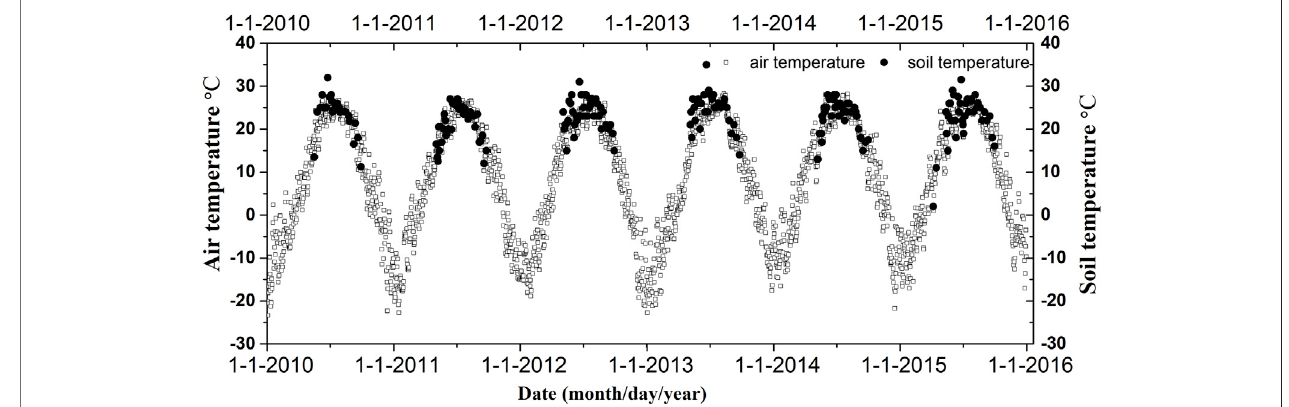
FIGURE 1 | Air temperature and soil temperature during the study period.